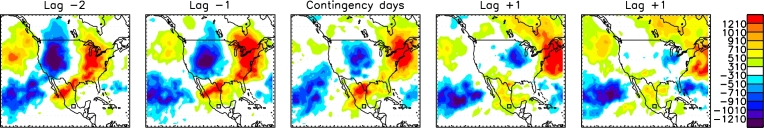
Composites of anomalies of potential temperature on the tropopause (−2 PVU surface) for extreme ozone events and 2 days before and 2 days after these events.